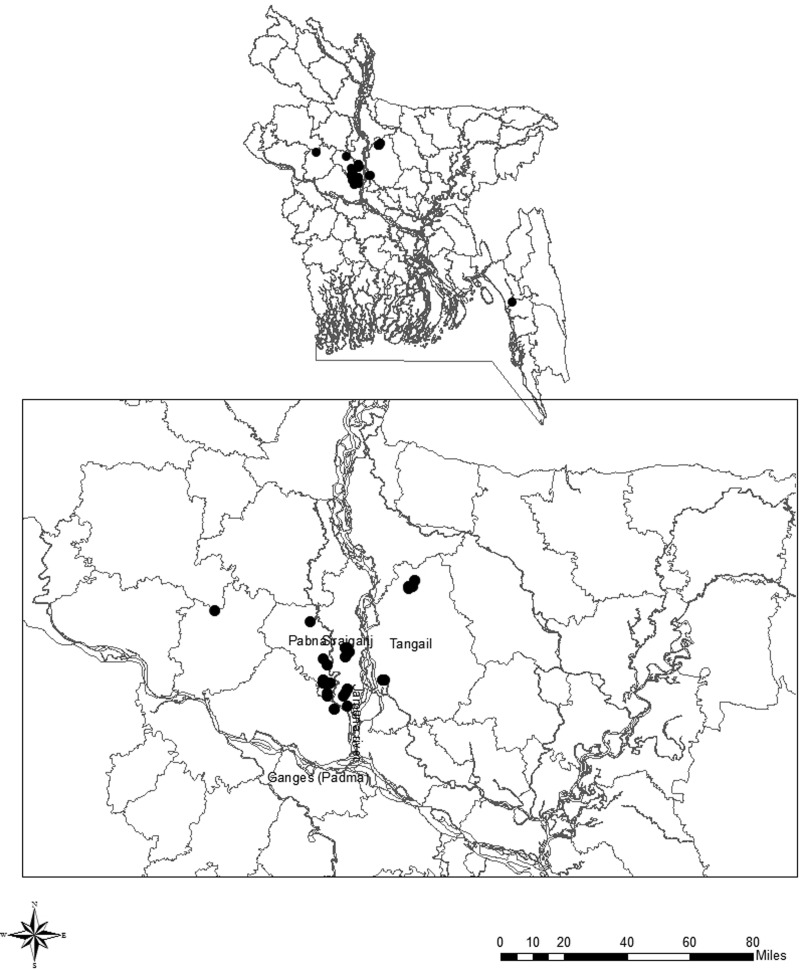
Geographical distributions of anthrax-affected cattle smallholdings observed in Bangladesh in October 2010–December 2015 that were enrolled in the study as the case farms; a closer view (at bottom) showing 41 of the 43 cases located in three adjoining districts: Pabna, Sirajganj and Tangail lying at the converging area of two rivers, Padma (Ganges) and Jamuna (western (main) branch of Brahmaputra).